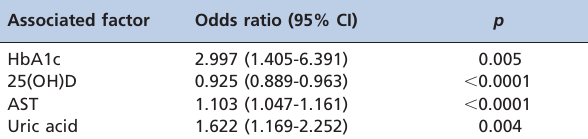
Table 2 - Results of the logistic regression analysis performed for